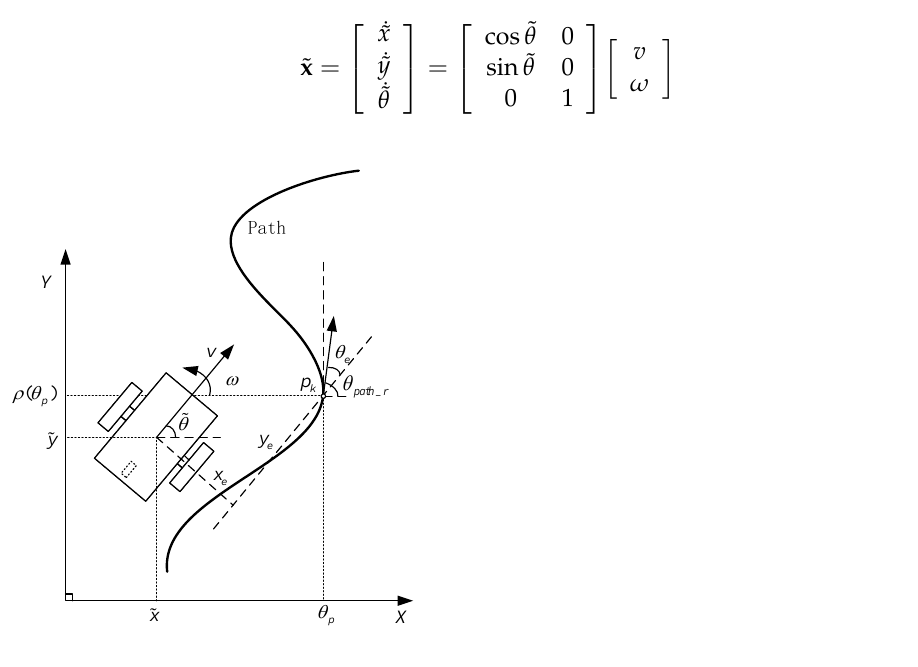
Figure 1. Mobile robot path-following